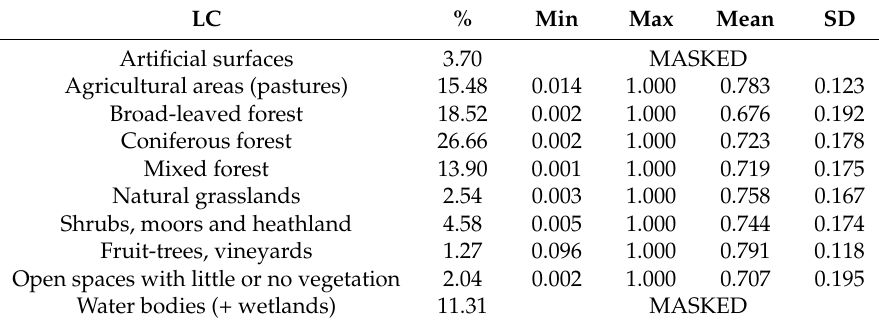
Table 2. Area of each land cover type and statistics of each cos γ i for each stratum. LC %